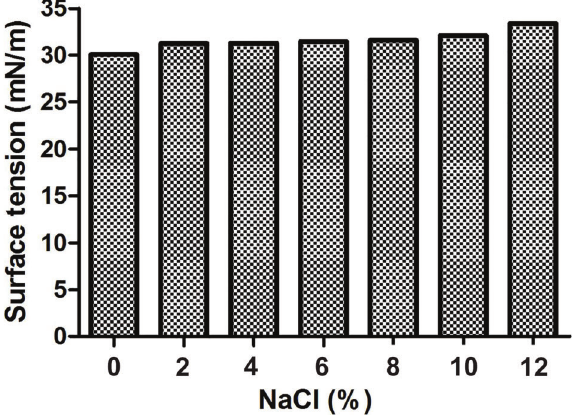
Figure 6. In fl uence of different sodium chloride concentrations on the surface tension of the biosurfactant after 96 h of fermentation.